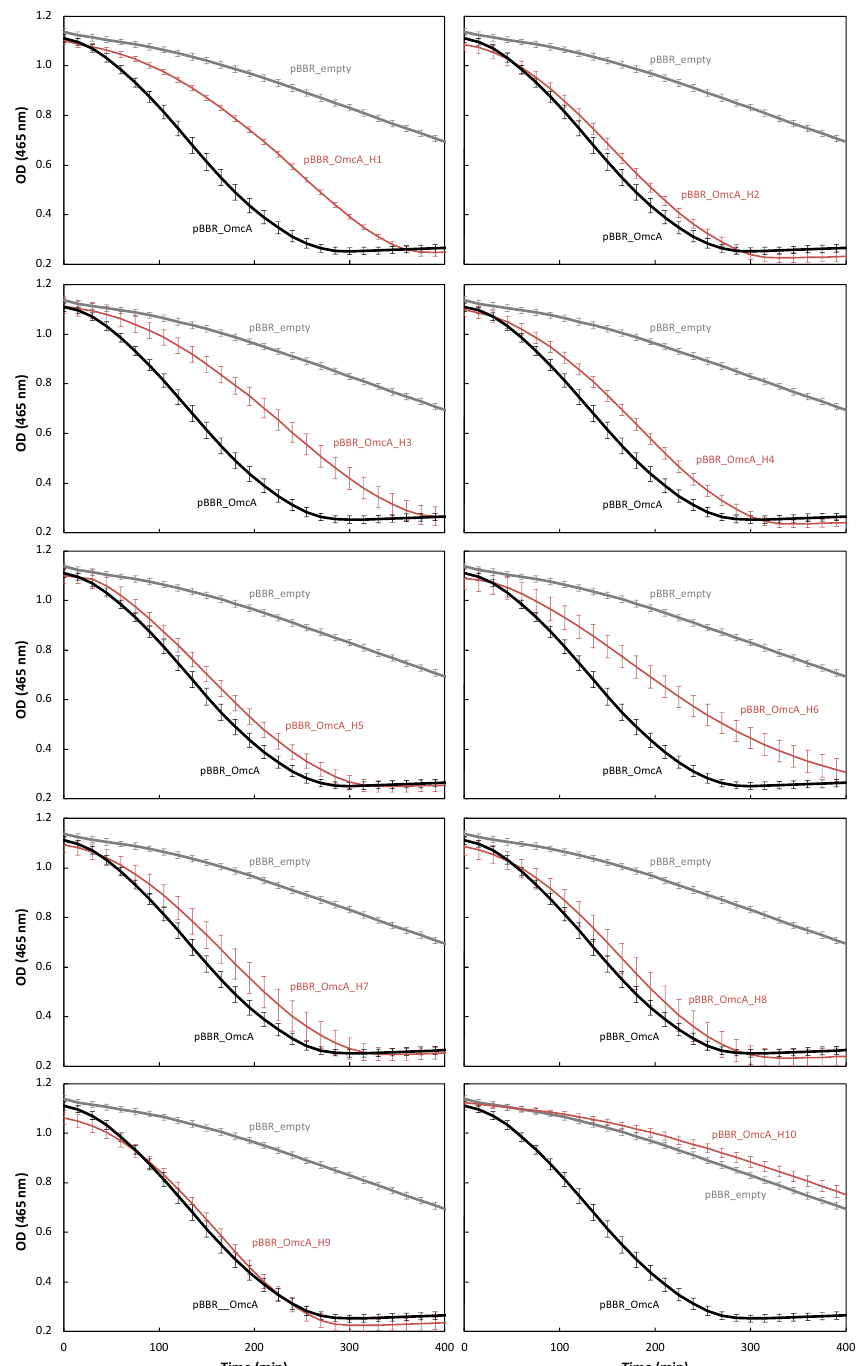
3.5. The Electroactivity of the Different OmcA Mutants in S. oneidensis Generally Matches the Reactivity with Methyl Orange The capacity of the S. oneidensis strains carrying different OmcA mutants in performing extracellular electron transfer was evaluated by the rate at which they decolorize methyl orange (Figure 4) and by the current produced in an electrode (Figures 5 and S5).